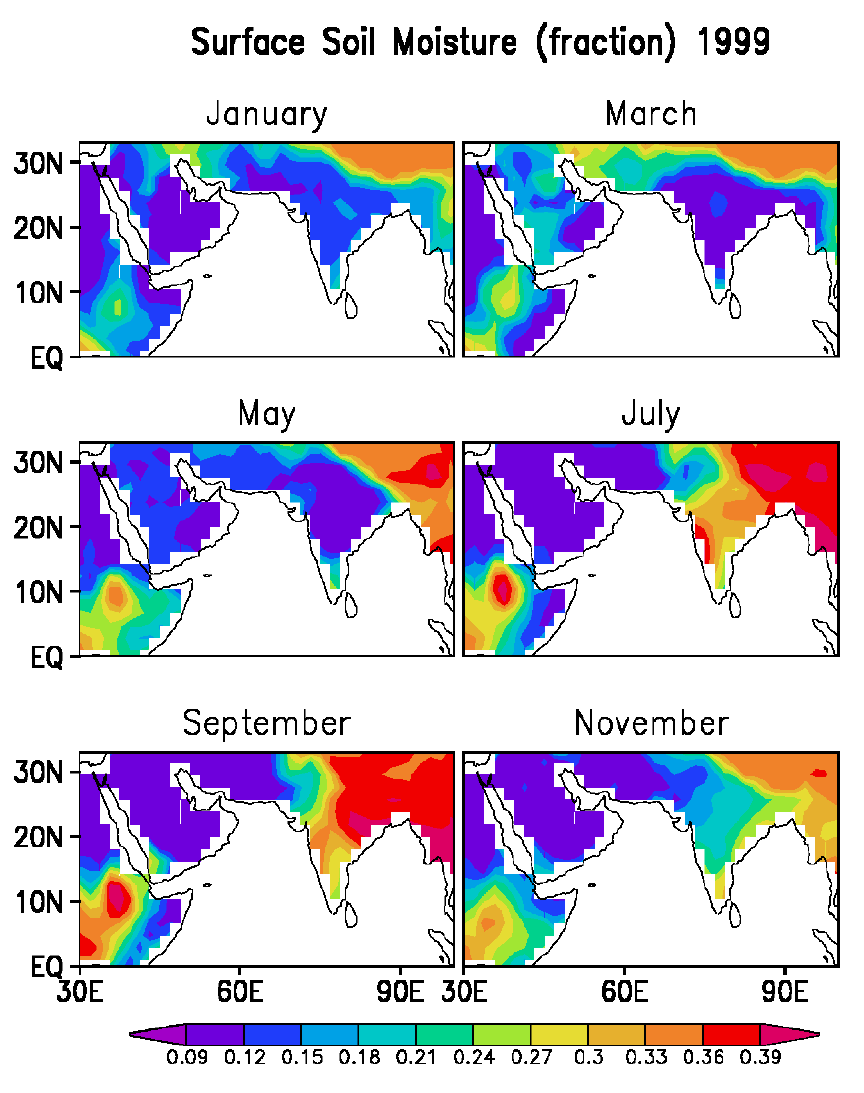
Fig. 10. The monthly average regional distribution of soil moisture during 1999 over India and adjacent continents for six representative